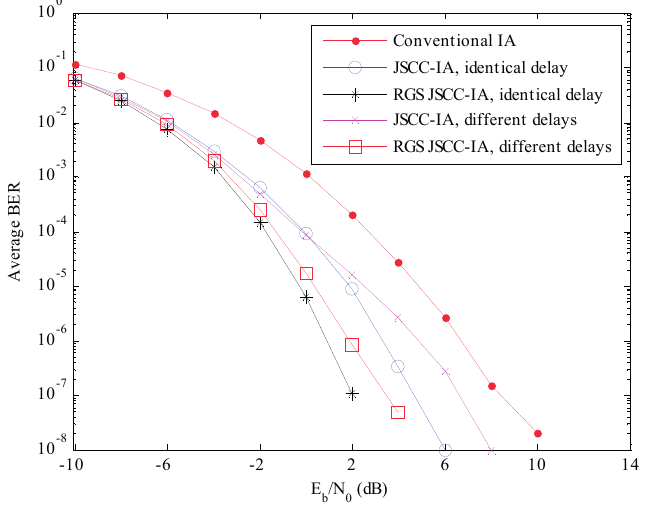
Figure 11. The average experimental BER performances of the conventional IA scheme, the JSCC-IA schemes with identical/different propagation delays and the RGS JSCC-IA schemes with identical/different propagation delays in the (4 × 4, 1) 20 asymmetric